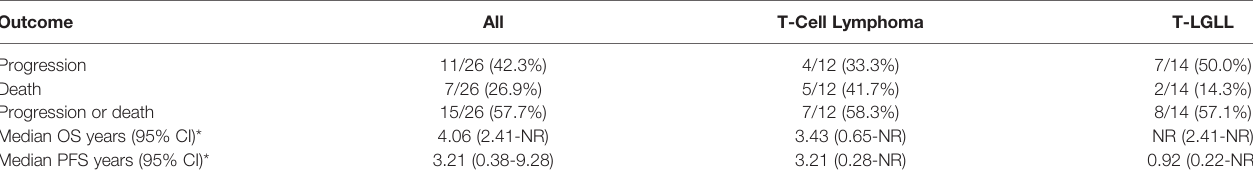
TABLE 4A | Progression and survival outcomes.